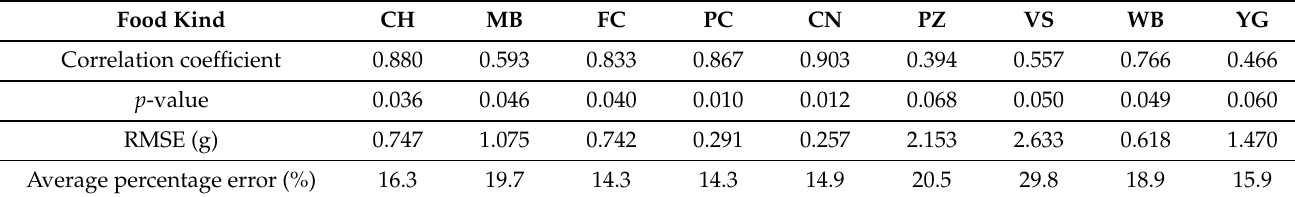
Table 1. The correlation coefficients, p -values, root mean square errors (RMSEs), and average percentage errors between the number of the chewing instances and food intake amount (g), for foods such as chicken breast (CH), mocha bread (MB), fried